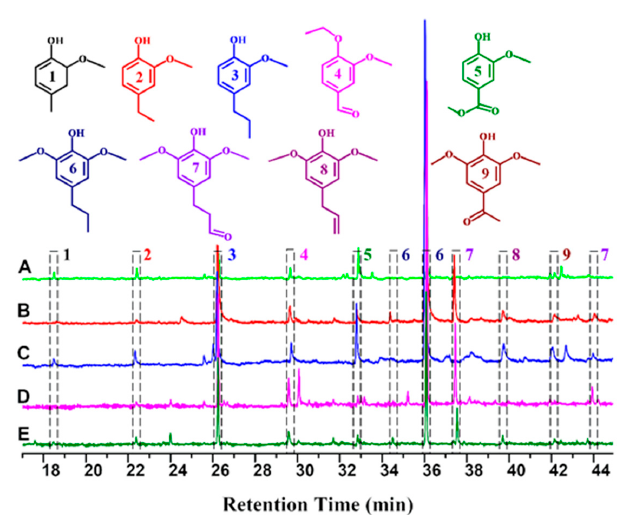
Figure 4. GC-MS chromatogram of the lignin monomers obtained from the degradation of different lignin samples and solvent systems. (A) L Control degraded in THF as the solvent system. (B) L FA degraded in THF as the solvent system. (C) L AA degraded in THF as the solvent system. (D) L FA degraded in MeOH as the solvent system. (E) L FA degraded in dioxane as the solvent system.